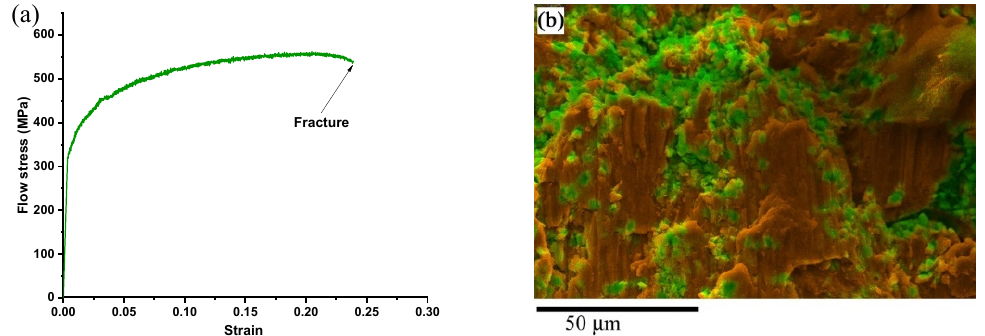
Figure 5. The strain dependence of flow stress under compression ( a ) and the fracture surface of the compressed V95\10% SiC metal matrix composite at room temperature ( b ): orange—the matrix; green—SiC particles.